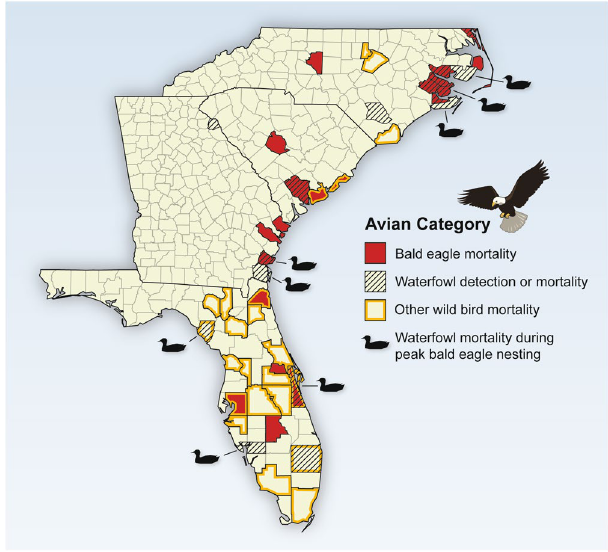
Figure 1. Regional highly pathogenic influenza. A virus in wild birds during Spring 2022 in the southeastern USA. Counties in North Carolina, South Carolina, Georgia, and Florida where H5 influenza A virus (IAV) (A/ goose/Guangdong/1/1996 lineage HP clade 2.3.4.4b H5N1) was detected in wild birds during Spring 2022, as reported by the U.S. Department of Agriculture (USDA; https:// www. aphis. usda. gov/ aphis/ ourfo cus/ anima